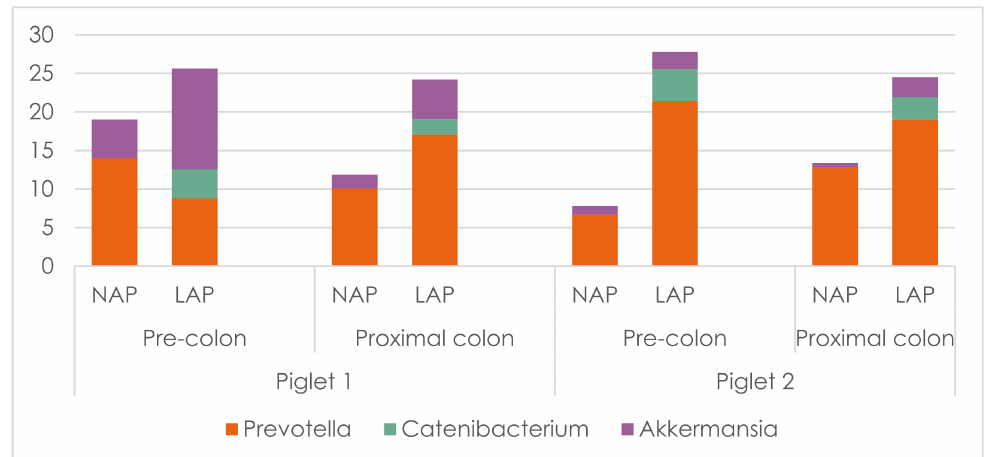
Figure 4. Relative abundances [%] of three genera observed in the pre-colon and proximal colon bioreactors of baby-SPIME showing significant differences when using AP (LAP) or not (NAP) for two donor